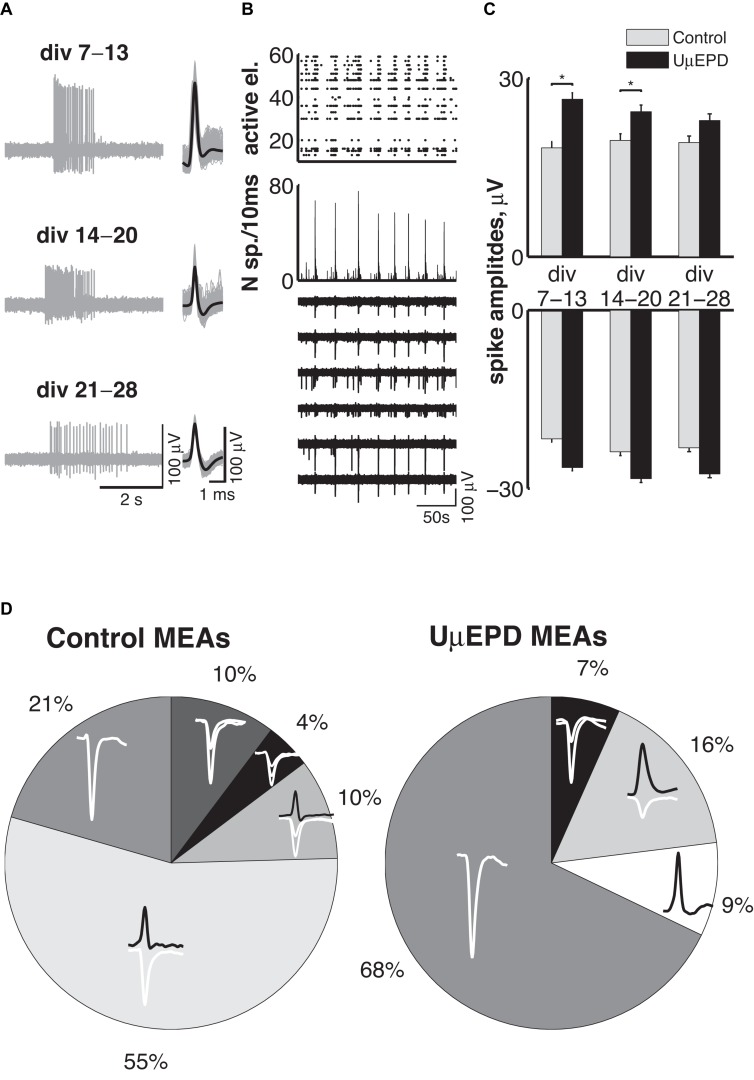
Biocompatibility, stability of ultramicroelectrodes, and spike-waveforms classification. Representative example of recordings from DIV7 up to DIV28 of spontaneous neuronal activity with PEDOT:PSS ultramicroelectrodes (A, left) and extracted spike waveforms (A, right); periodic synchronized network behavior within 200 s is presented by spike-time (black dots) raster plot over all PEDOT:PSS ultramicroelectrodes (B, top), histogram of spike time computed for 10 ms intervals across all microelectrodes (B, middle) and extracellular recording with six PEDOT:PSS ultramicroelectrodes (B, bottom) during corresponding time; the distribution of the average amplitudes with positive (C, top) and negative (C, bottom) deflections over 3 weeks of neuronal network development detected with control (gray bars, n = 12 MEAs) and PEDOT:PSS ultramicroelectrodes (black bars, n = 10 MEAs) microelectrodes, data are shown as mean ± SEM; classification of spike waveforms detected by planar microelectrodes (D, left, n = 4 MEAs) revealed that the majority (79%) of planar electrodes detects signal with several different spike shapes simultaneously, whereas the majority of PEDOT:PSS ultramicroelectrodes (77%) microelectrodes registered only single waveform of spikes (D, right, n = 7 MEAs).